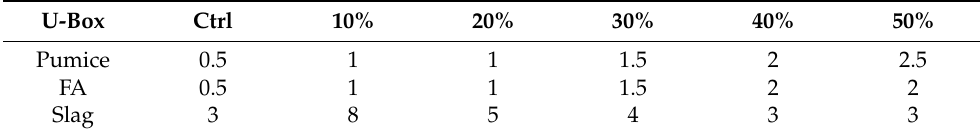
Table 3. U-box test value for each binary samples.